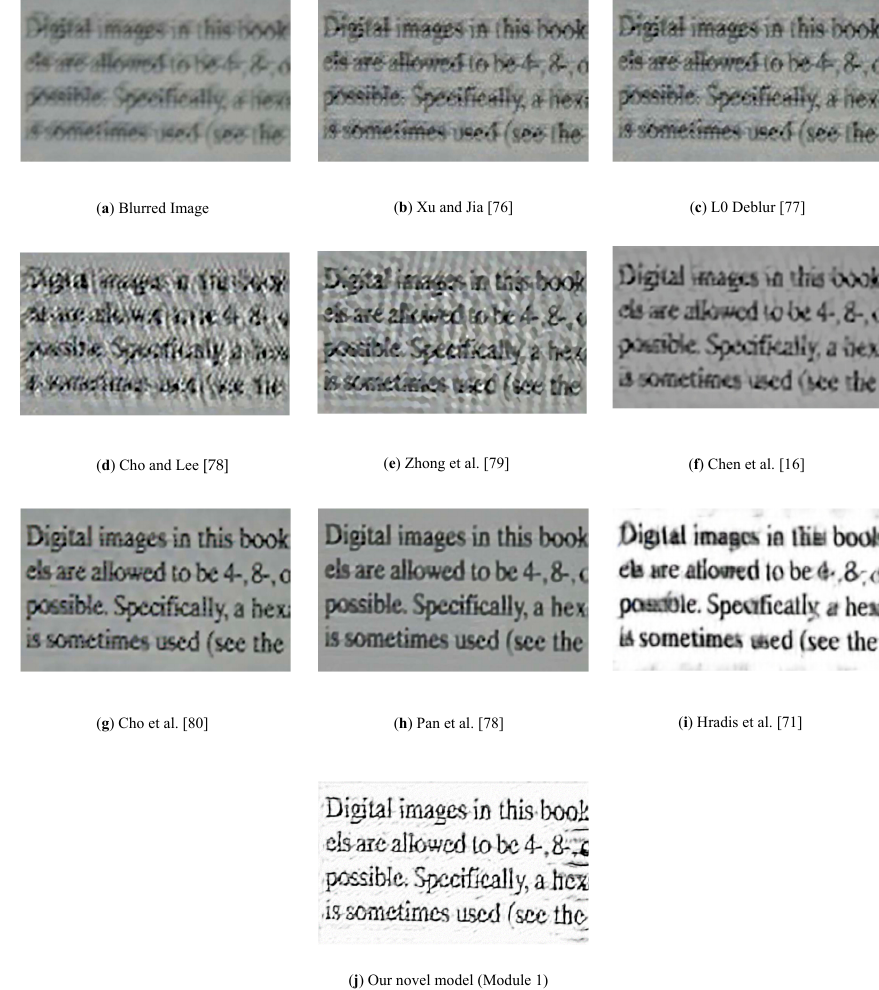
Figure 7. Comparison with respect to blur enhancement between our model and different related models from the relevant literature. Image ( a ) shows the blurred input image; this image is used to test all models involved in this comparison. Most of those algorithms, except model ( i ), are using analytical models, but model ( i ) and our model ( j ) are using CNN. This is why these two last-named models are also improving the image’s contrast.